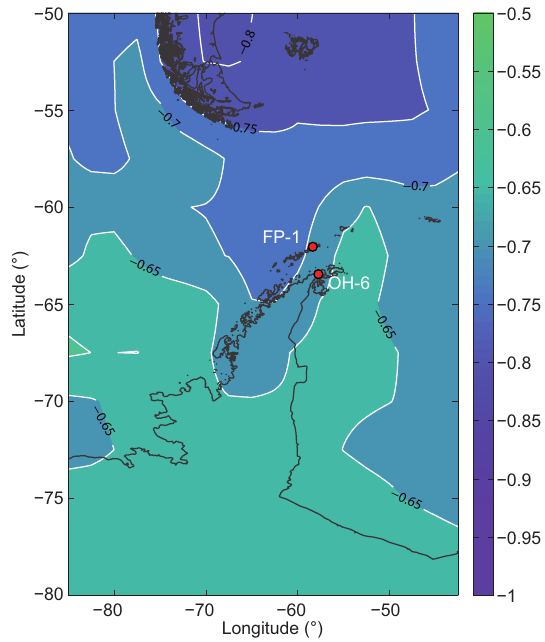
Fig. 15. Spatial correlation of the calculated d excess monthly mean composite from the firn cores FP-1 and OH-6 (red points) against air temperature (at surface level) from NCEP reanalysis. The color scale represents the correlation coefficient ( r